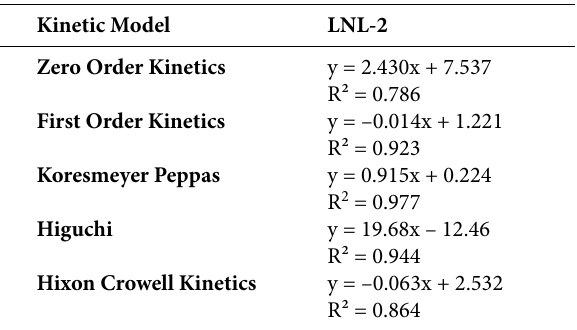
Table 3. In vitro drug release kinetics with R 2 values of selected for- mulation